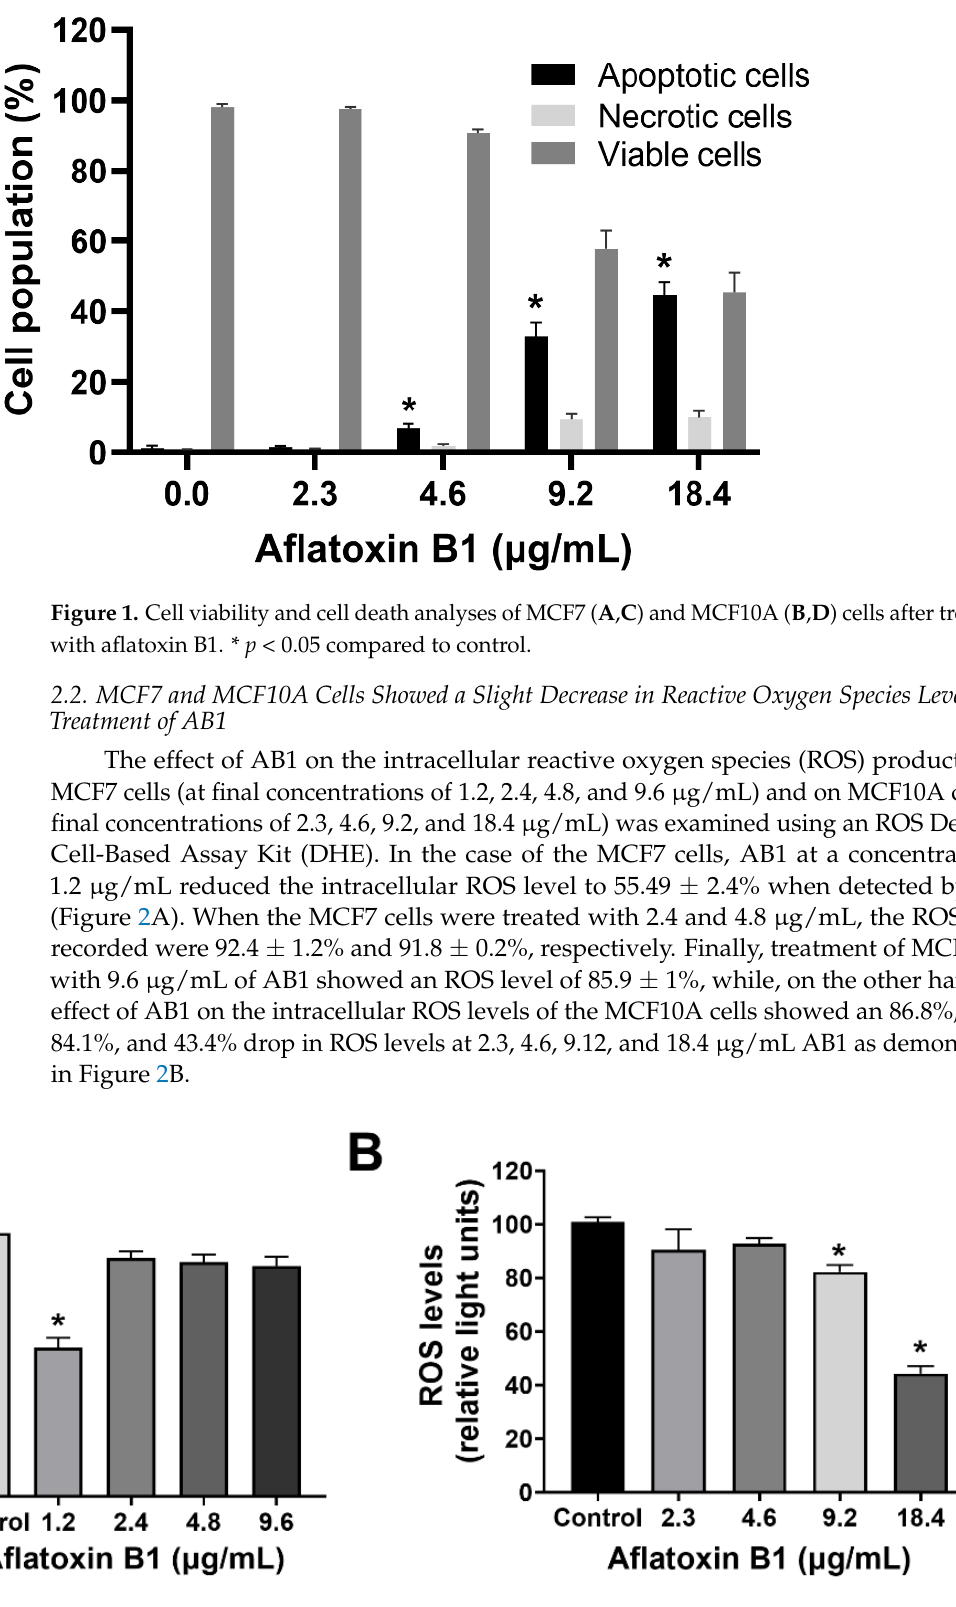
Figure 1. Cell viability and cell death analyses of MCF7 ( A , C ) and MCF10A ( B , D ) cells after treat- ment with aflatoxin B1. * p < 0.05 compared to control.